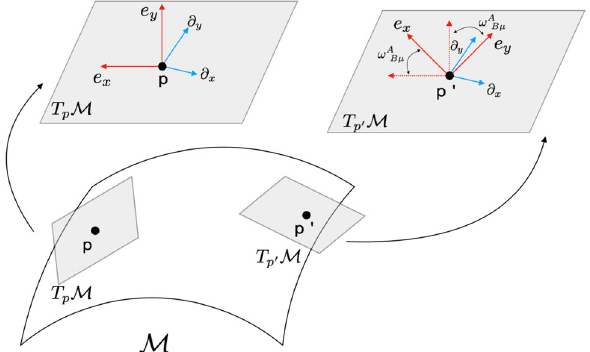
Fig. 6 Two-dimensionalpicturedisplayingtheroleofthespinconnec- tion ω A . It translates the inertial effects present in the tetrad anholo- (cid:5) (cid:4) B μ e x , e y . When we pass from p ∈ M to p (cid:14) ∈ M , the nomic frame related tetrads in T p M and T p (cid:14) M exhibit a rotation, modeled by the spin connection. Instead, the inertial holonomic frame